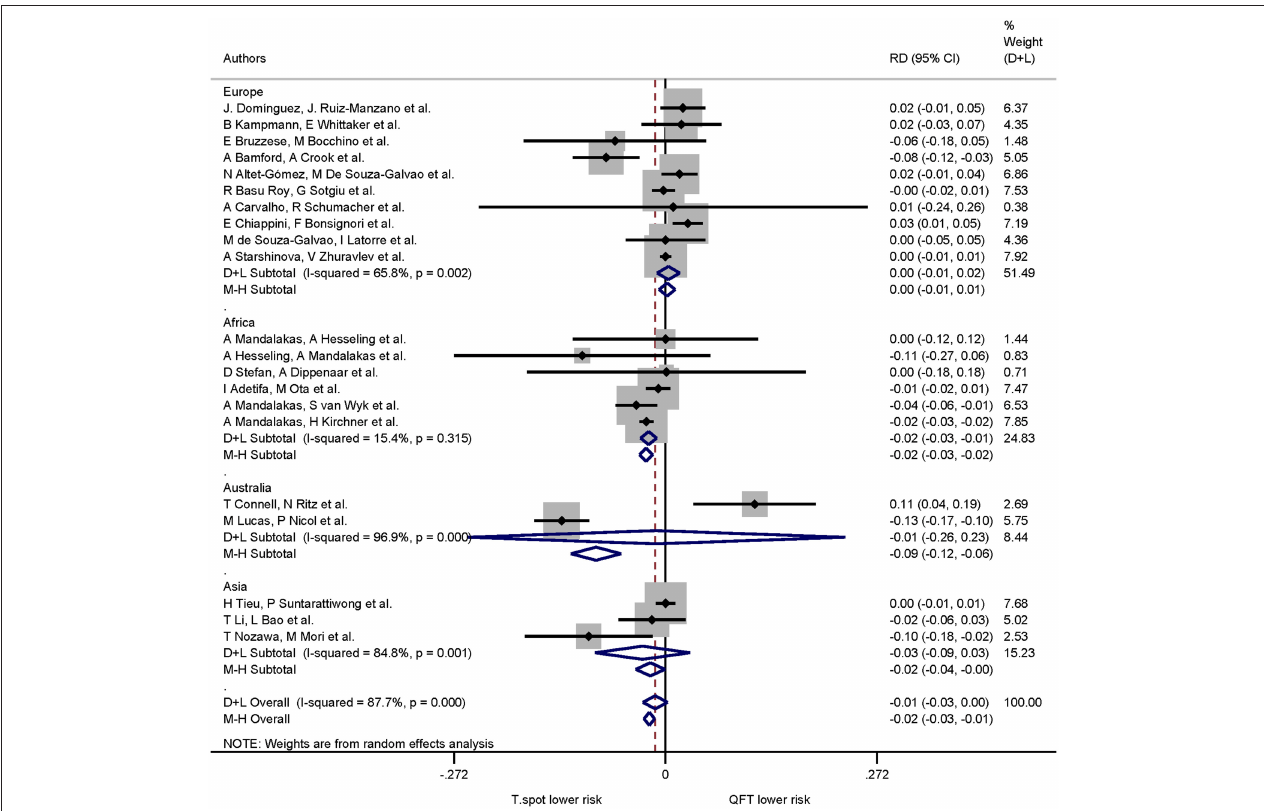
FIGURE 5 | Risk differences (RD) with 95% CI in studies that included a head-to-head comparison of QuantiFERON-TB and T-SPOT.TB assays stratified by continent. Studies arranged according to year of publication.